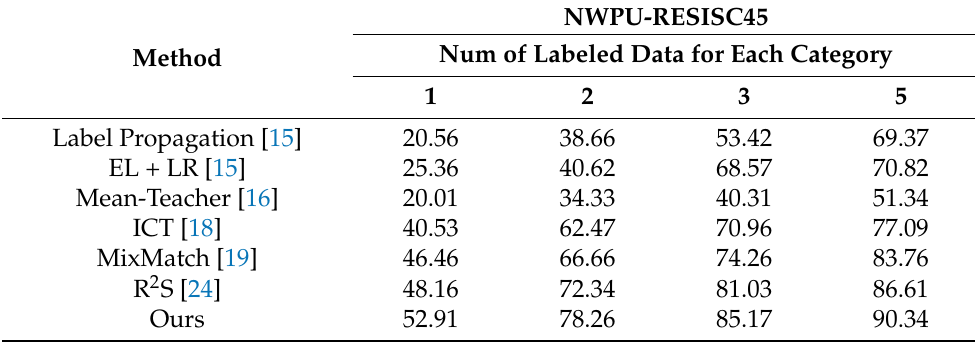
Table 1. Recognition accuracy (%) of label propagation, EL + LR, Mean-teacher, ICT, MixMatch, and our proposed method with differently labeled data for each category on NWPU-RESISC45